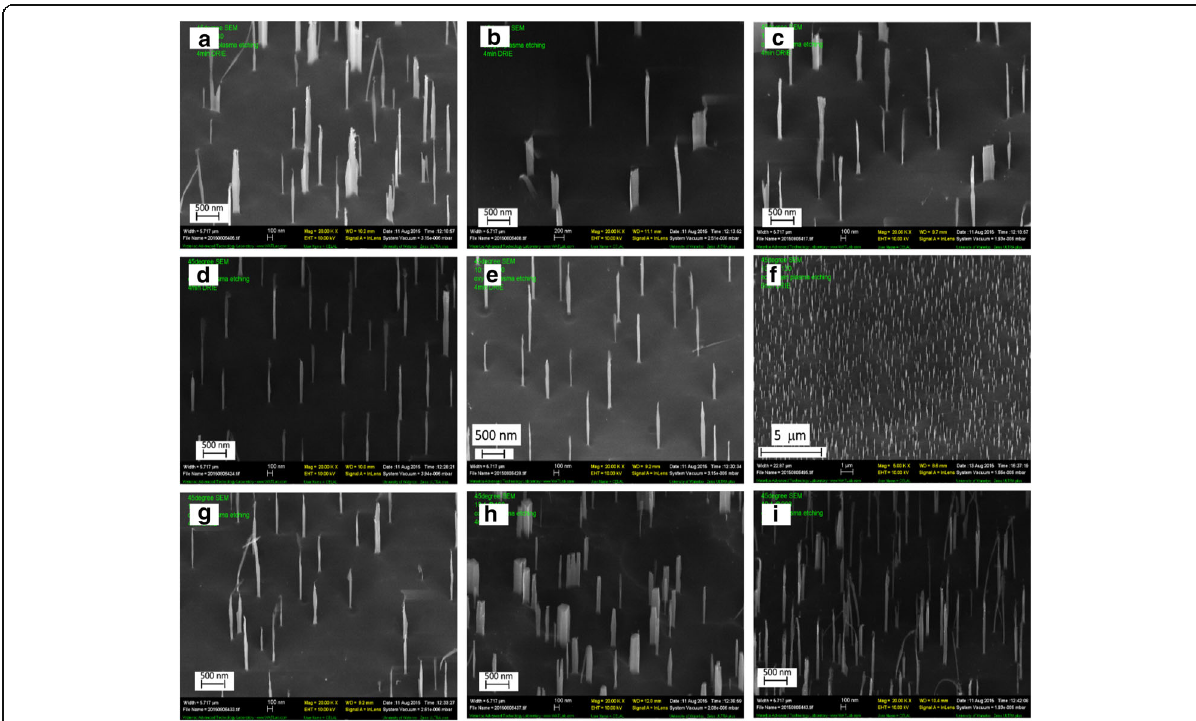
Fig. 3 SEM images of silicon nanostructures with 1:10 ANN:PMMA ratio annealed at different temperatures. a 40 °C, b 50 °C, c 80 °C, d 100 °C,